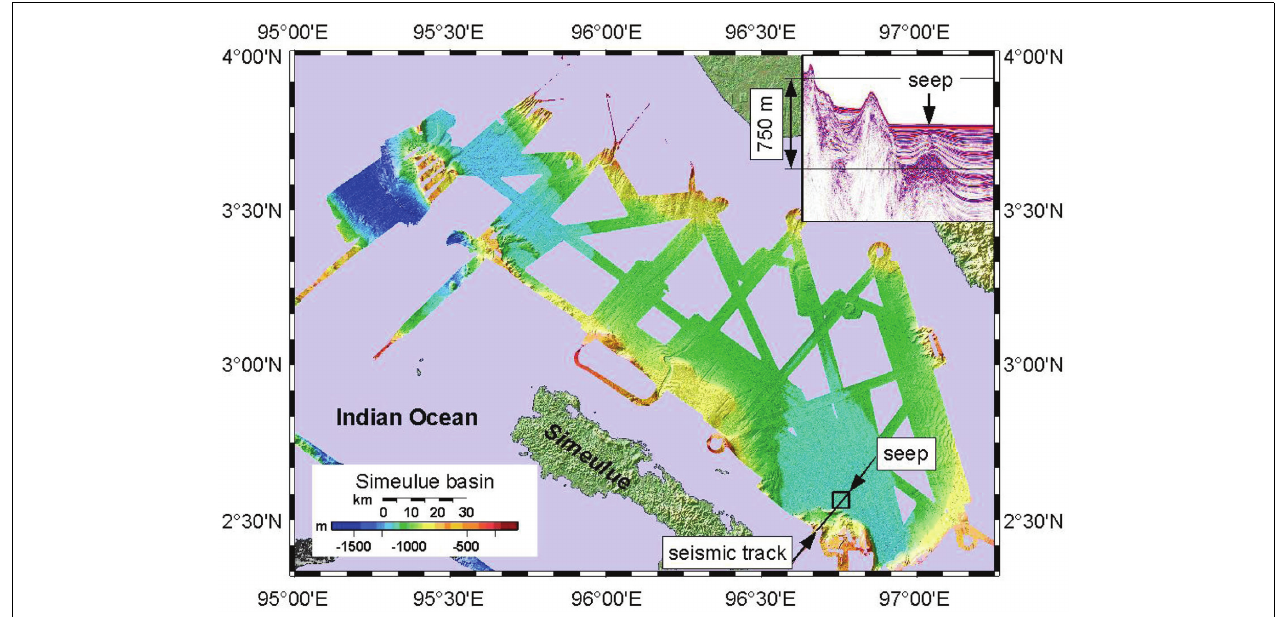
FIGURE 2 | Bathymetric map of the Simeulue basin with the seep area in the SE. The insert (covering the island Sumatra) shows a seismic profile of the track drawn in the SE. 750m is an approximate value.